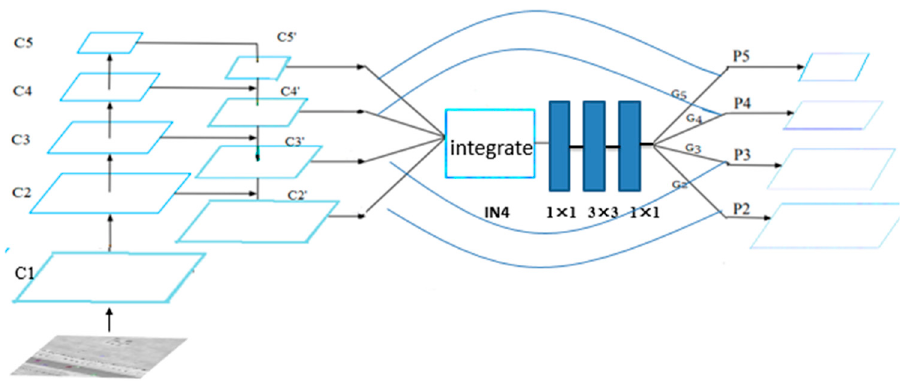
Figure 2. The structure of feature-balanced pyramid network (FBPN).